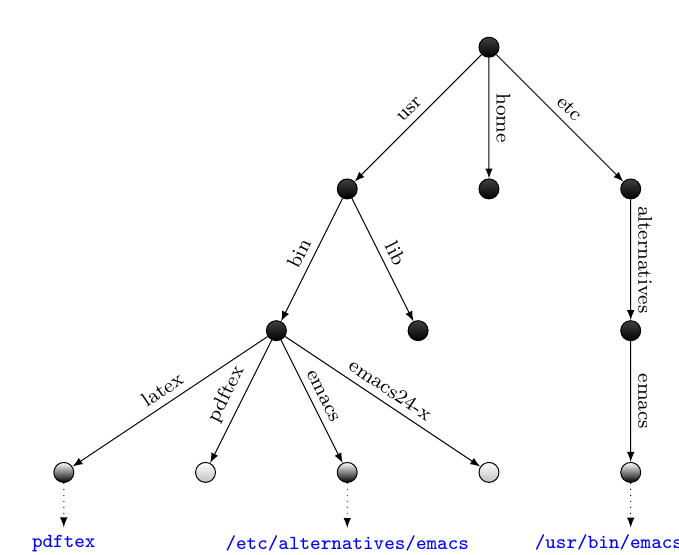
Fig. 1. Excerpt of the file system tree typically found in a Debian installation. Black nodes denote directories, white nodes denote regular files, and gray nodes denote symbolic links. the NUL character (i.e. ASCII code 0). The filenames "." and ".." have special meanings, respectively the current and the parent directory. When the given path- name is absolute, pathname resolution starts from the root directory, otherwise it starts from the current directory of the process that attempts resolution. Figure 1 presents an excerpt of the real file system tree that appears in a computer with a typical Debian installation. Notice the relative symbolic link /usr/bin/latex that points to pdftex , that is /usr/bin/pdftex as an absolute path, and the absolute symbolic link /usr/bin/emacs that points to /etc/alternatives/emacs which is itself a symbolic link to /usr/bin/emacs24-x